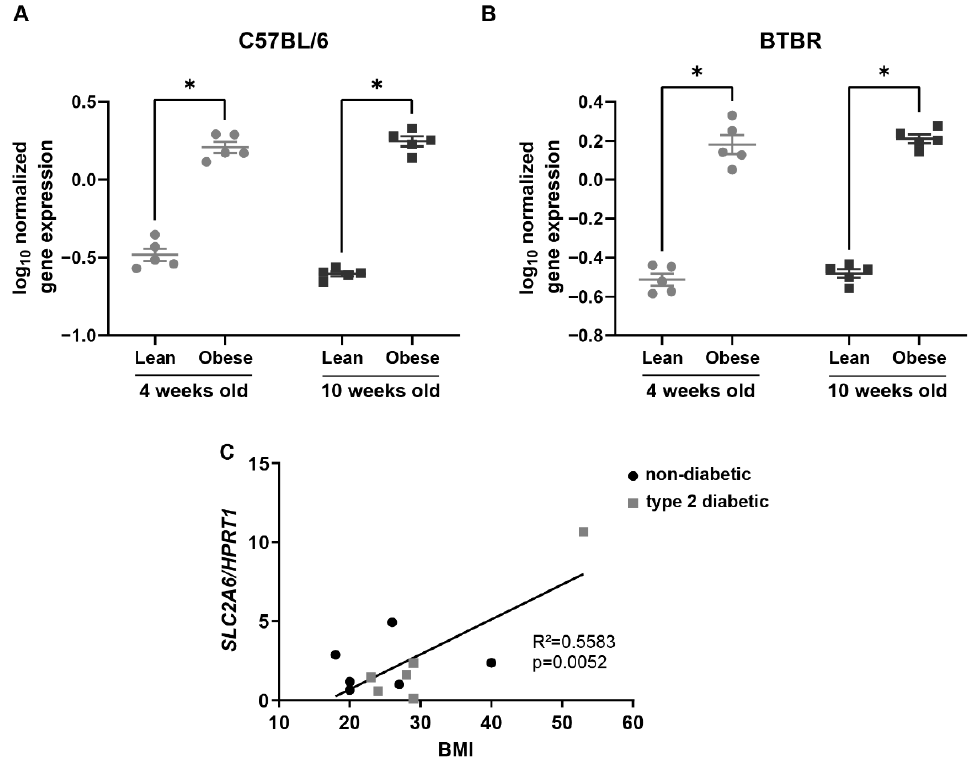
Figure 1. Expression of Slc2a6 mRNA is increased in islets from obese ( ob/ob ) mice and correlates with body mass index in human islets. ( A , B ) Slc2a6 expression in isolated islets obtained from lean ( ob/+ and +/+ , grey circles) or obese ( ob/ob , black squares) male mice (Attie Lab Diabetes Database in the form of “mlratio”, which is the log10 of the ratio of gene expression for the experimental sample to a strain-specific reference pool for either C57BL/6 ( A ) or BTBR ( B ) mice). ( C ) Human islet SLC2A6 expression positively correlated with body mass index (BMI). Islets were isolated from non-diabetic humans (black circles) and humans with type 2 diabetes (grey squares). * indicates p < 0.05 by two-way ANOVA. n = 5 mice per group ( A , B ), n = 12 human samples ( C ).